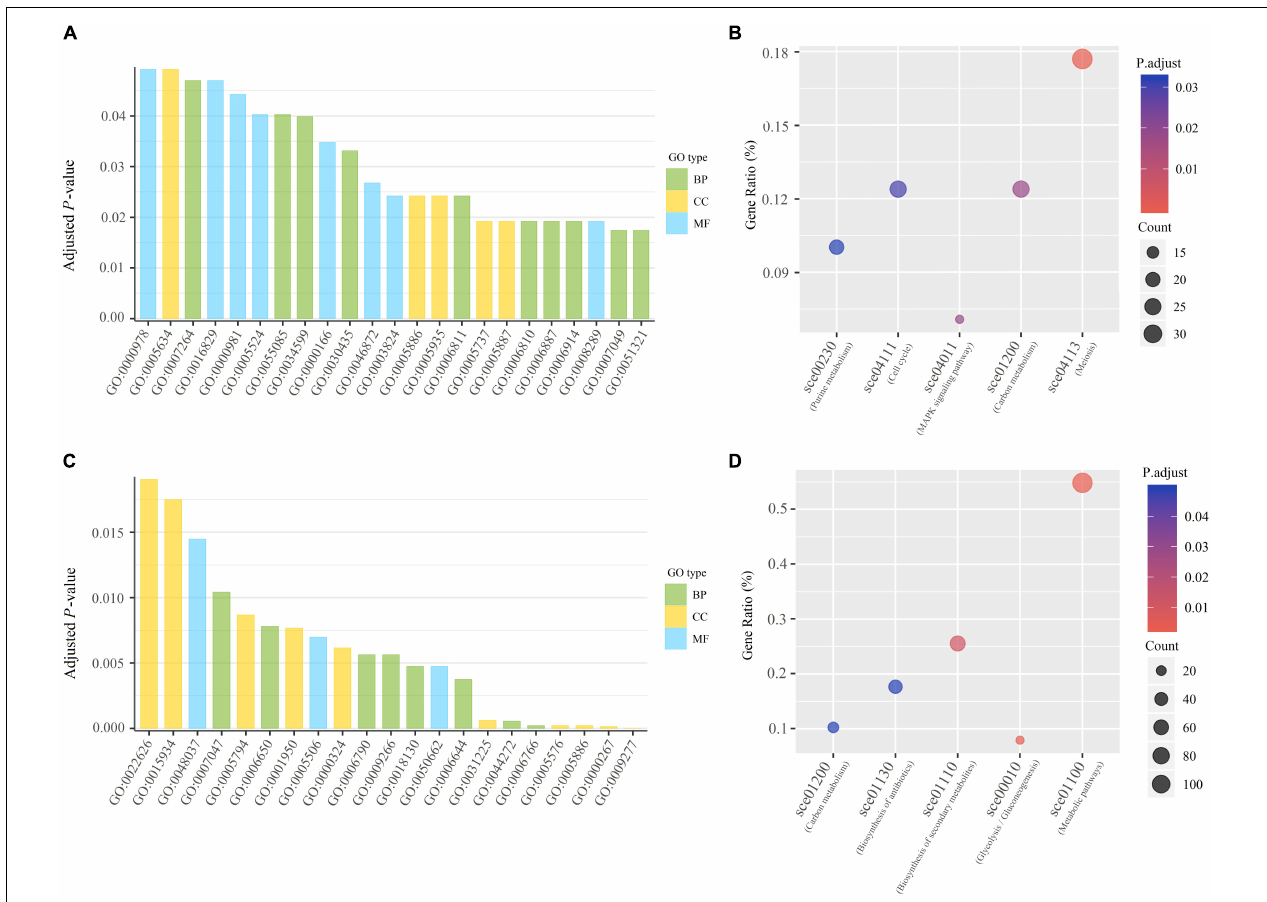
FIGURE 2 | Functional analysis of genes adjacent to replication origins. (A) GO enrichment analysis of 662 conserved genes adjacent to conserved ARSs. GO terms with the adjusted p -value ≤ 0.05 are shown. The statistical significance was assessed by Fisher’s exact test with False discovery rate (fdr) correction. BP for the biological process; MF for molecular function; CC for the cellular component. (B) Scatterplot for significantly enriched KEGG pathways of 662 conserved genes adjacent to conserved ARSs. KEGG pathways with the adjusted p -value ≤ 0.05 are shown. The statistical significance was assessed by Fisher’s exact test with fdr correction. The size and color of dots represent the gene number and the adjusted p -value, respectively. Gene ratio is the proportion of enriched genes among all conserved genes neighboring ORIs. (C) GO enrichment analysis of genes adjacent to non-conserved ARSs. (D) Scatterplot for significantly enriched KEGG pathways of genes adjacent to non-conserved